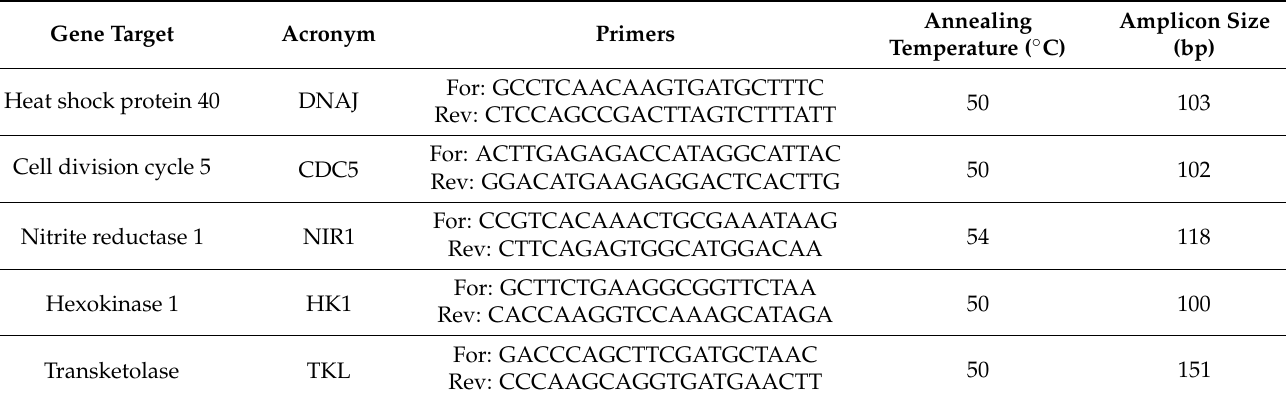
Table 2. List of primers for confirmatory analyses by qRT-PCR.